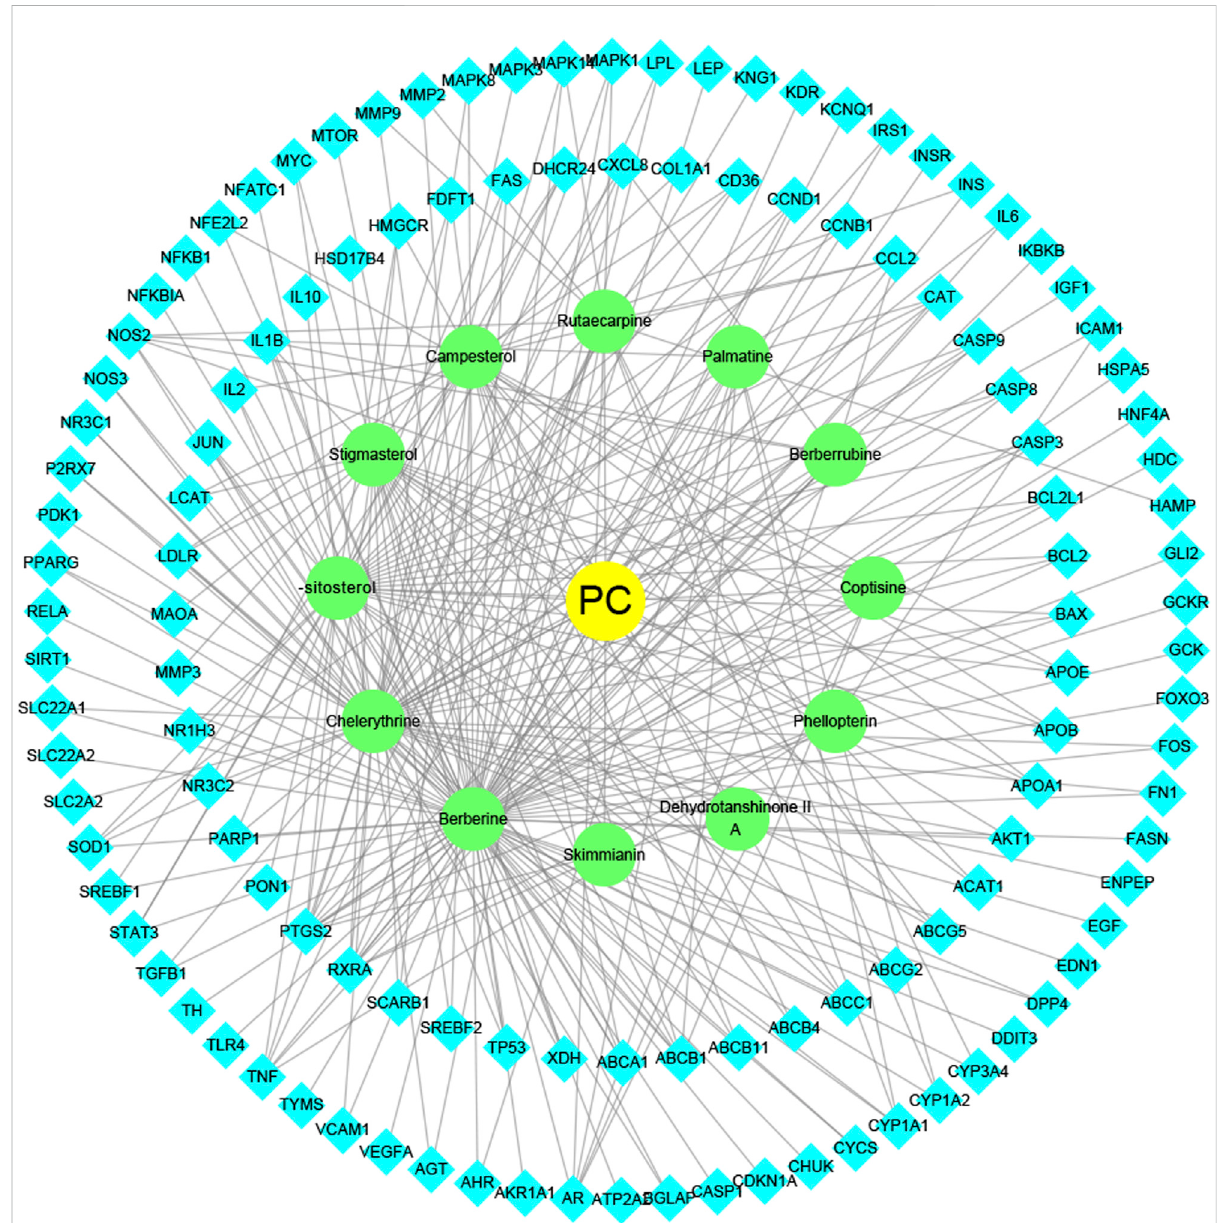
FIGURE 3 Theherb-ingredient-targetnetworkofCP.TheyellownodesrepresentCP,thegreennodesrepresentactiveherbalingredients,thecyannodes represent target proteins, and the lines represent the interactions between